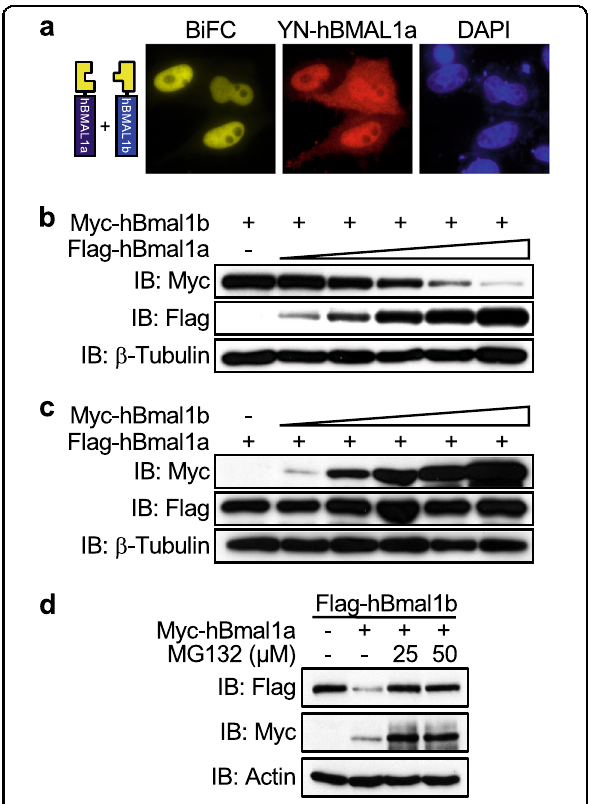
Fig. 3 hBMAL1a promotes the proteolysis of hBMAL1b. a The direct interaction between hBMAL1a and hBMAL1b was visualized by the BiFC assay using YN-Flag-fused hBmal1a and YC-fused hBmal1b. b , c Fixed amounts of Myc-hBmal1b or Flag-hBmal1a were co- transfected into HeLa cells with increasing amounts of Flag-hBmal1a or Myc-hBmal1b, respectively. Levels of Myc-hBMAL1a or Flag- hBMAL1b were detected by western blotting. d Flag-hBmal1b was transfected alone or together with Myc-hBmal1a into HeLa cells. After an overnight incubation, a potent protease inhibitor, MG132, was applied to the transfected cells as indicated. After 5 h incubation, levels of hBMAL1 isoforms were analyzed by western